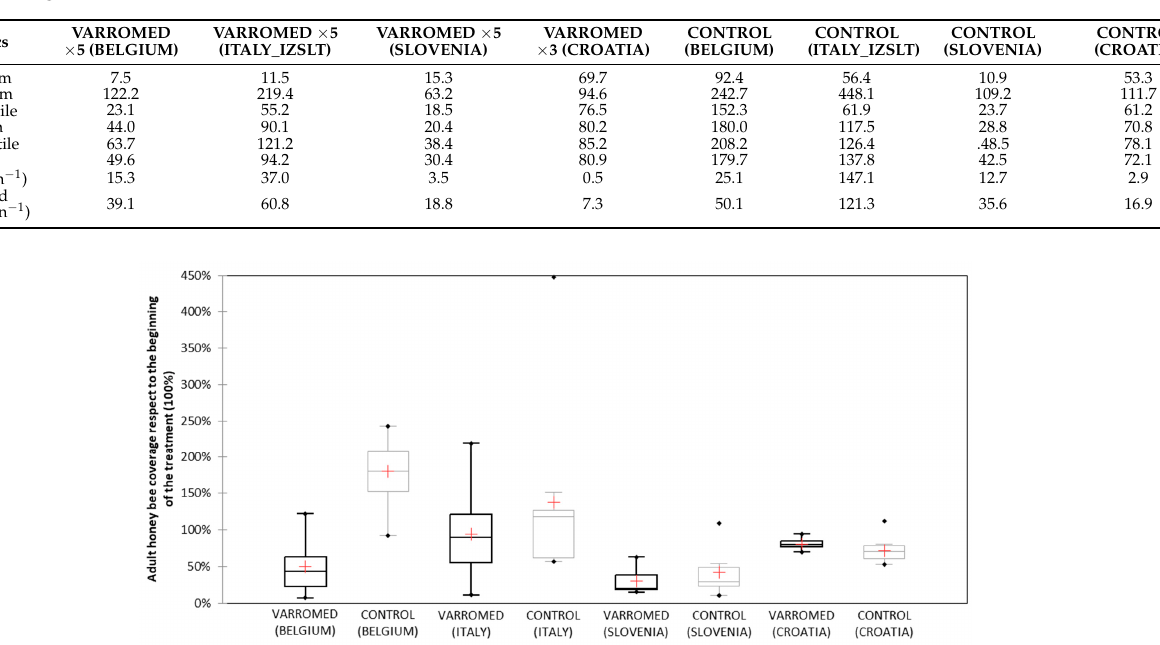
Table 3. Variation of adult honey bee coverage in all groups recorded during the summer/autumn trial compared to the beginning of the treatment (%).